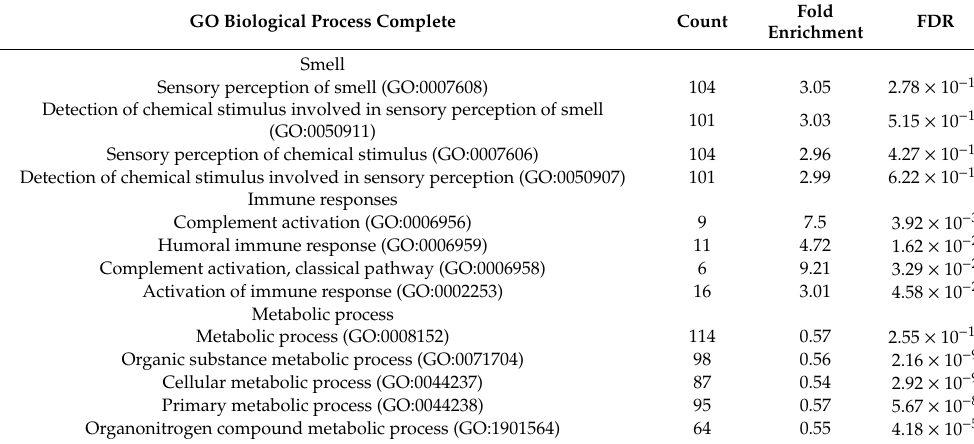
Table 4. Gene Ontology (GO) reveals three cattle sharing high or moderate e ff ects > 5